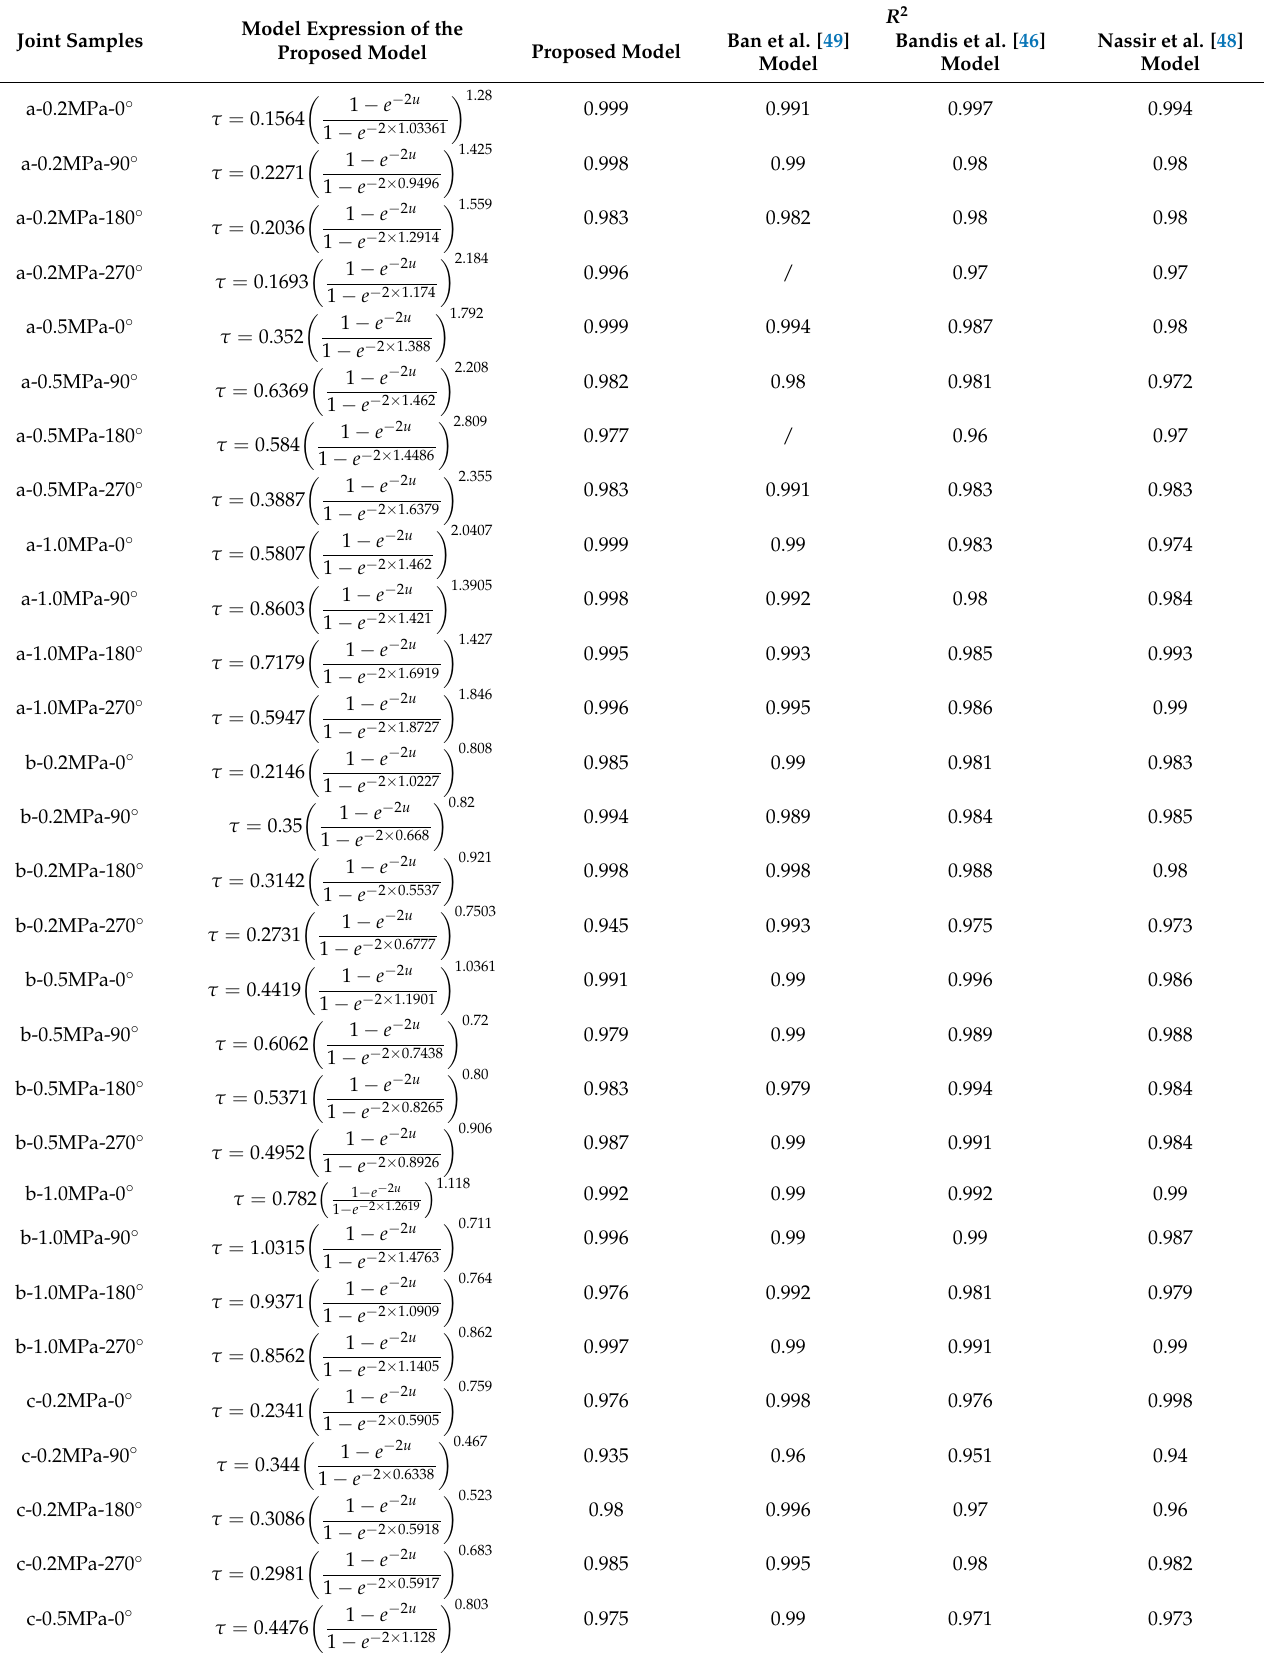
Table 2. Fitting effect of model and experimental